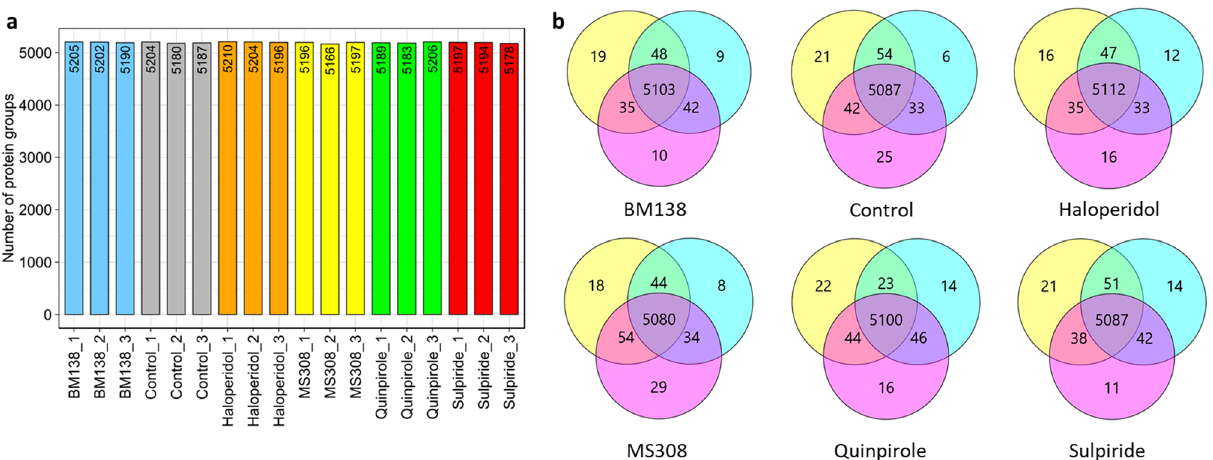
Figure 2. Overview of identified protein groups (PGs) of D 2S R expressing HEK293T cells incubated with the